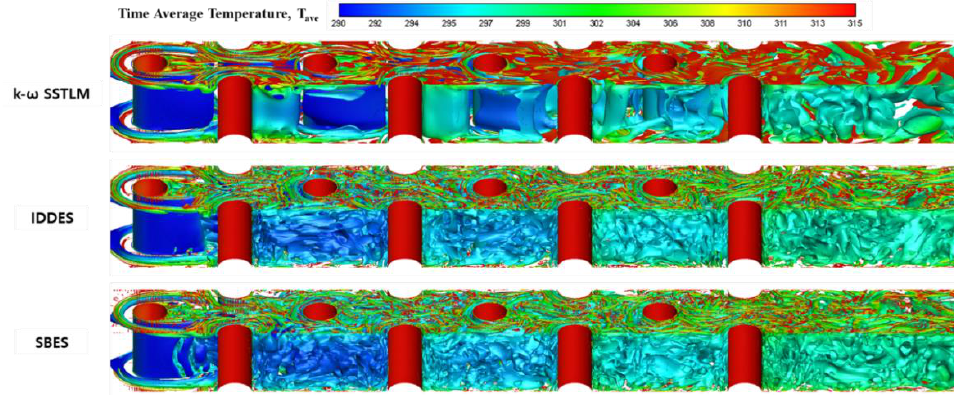
Figure 11. Vortical structures around pin fin array, Q isosurface (Q = 10) colored by T ave for each turbulence model.